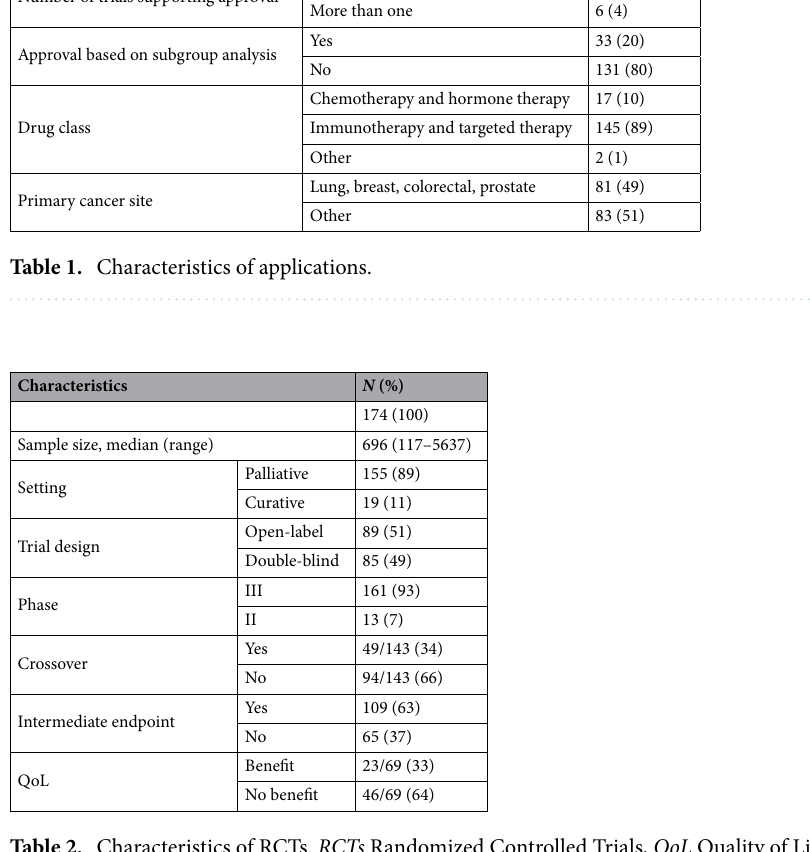
Table 2. Characteristics of RCTs. RCTs Randomized Controlled Trials, QoL Quality of